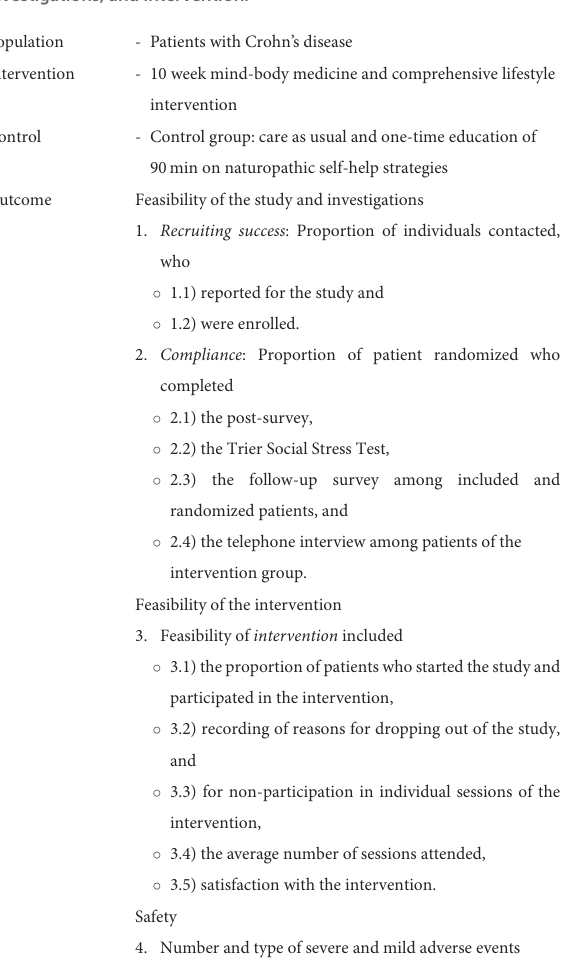
TABLE 1 P.I.C.O. model endpoints focused on study feasibility, investigations, and